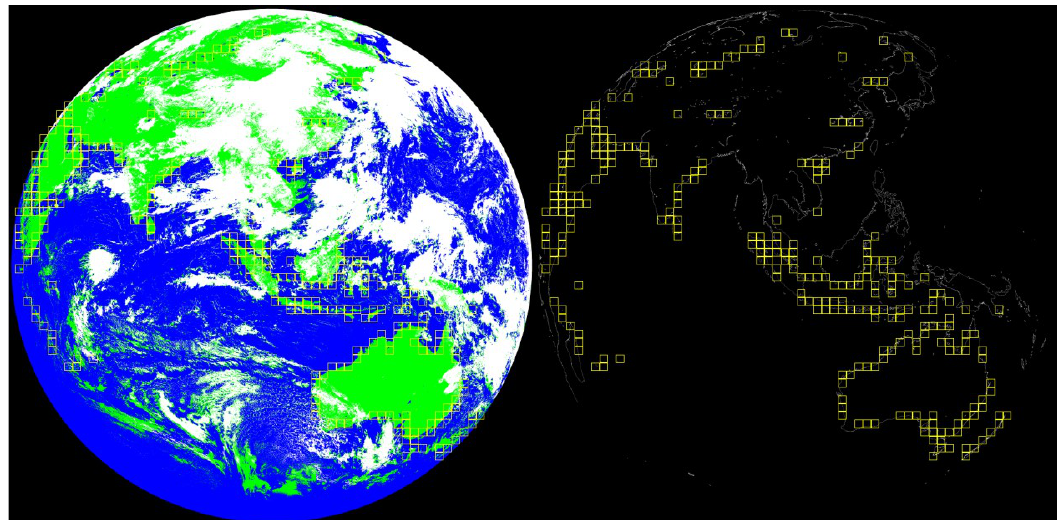
Figure 2. Landmark data set (yellow grid is landmark, left image is classified image superimposed landmark, right image is the coastline template superimposed